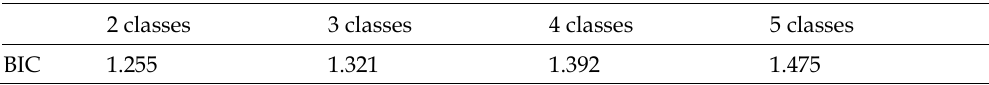
Table 4 BIC values for base models with different number of